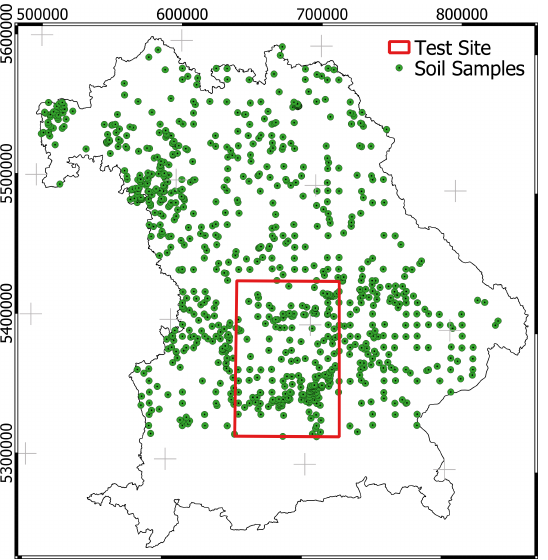
Figure 2. Test site location in Bavaria and the distribution of soil samples. Projection: EPSG 31468 (https://spatialreference.org/ref/epsg/31468; accessed on 13 March